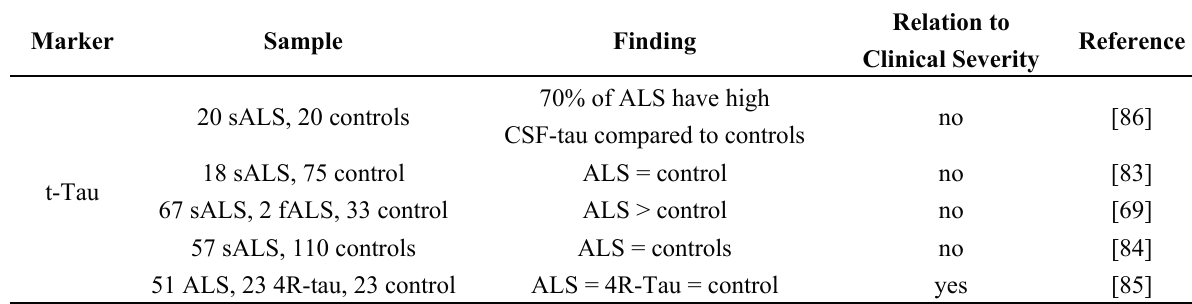
Table 3. CSF levels of total Tau-protein (t-Tau) in Amyotrophic Lateral Sclerosis (ALS) as compared to healthy controls and other diseases associated with 4-Repeat-Tauopathy (4R-Tau). Marker Sample